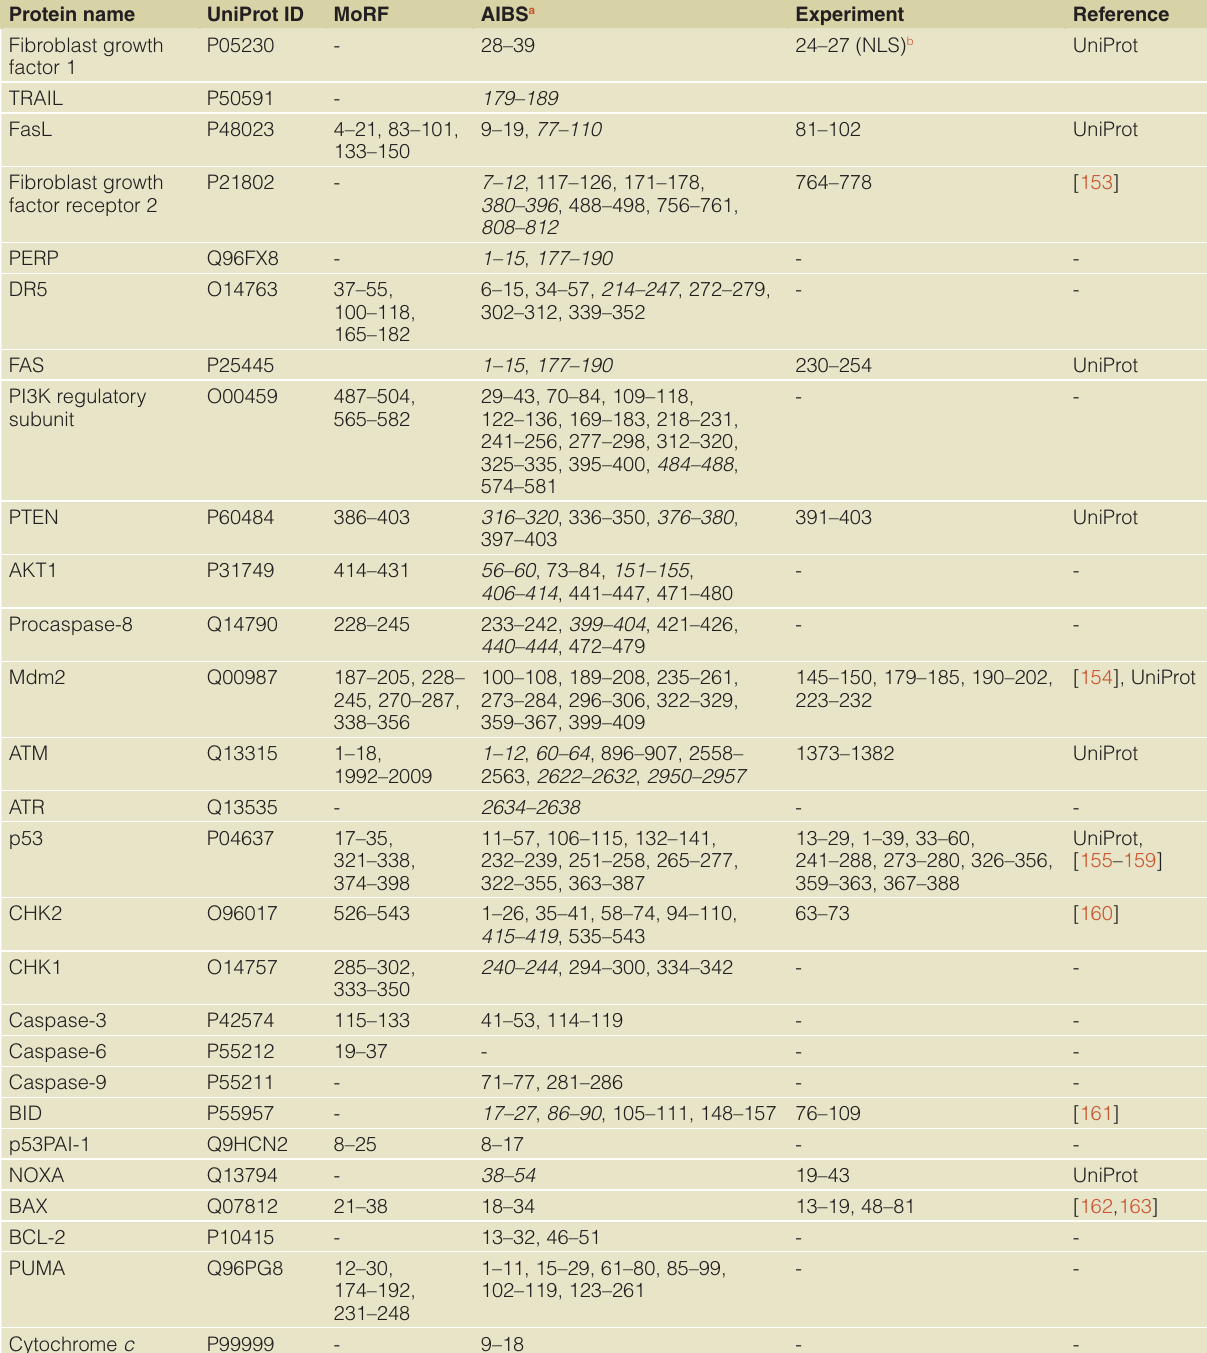
Table 2. Abundance of disorder-based binding sites in proteins involved in the p53-mediated apoptotic pathways. Protein